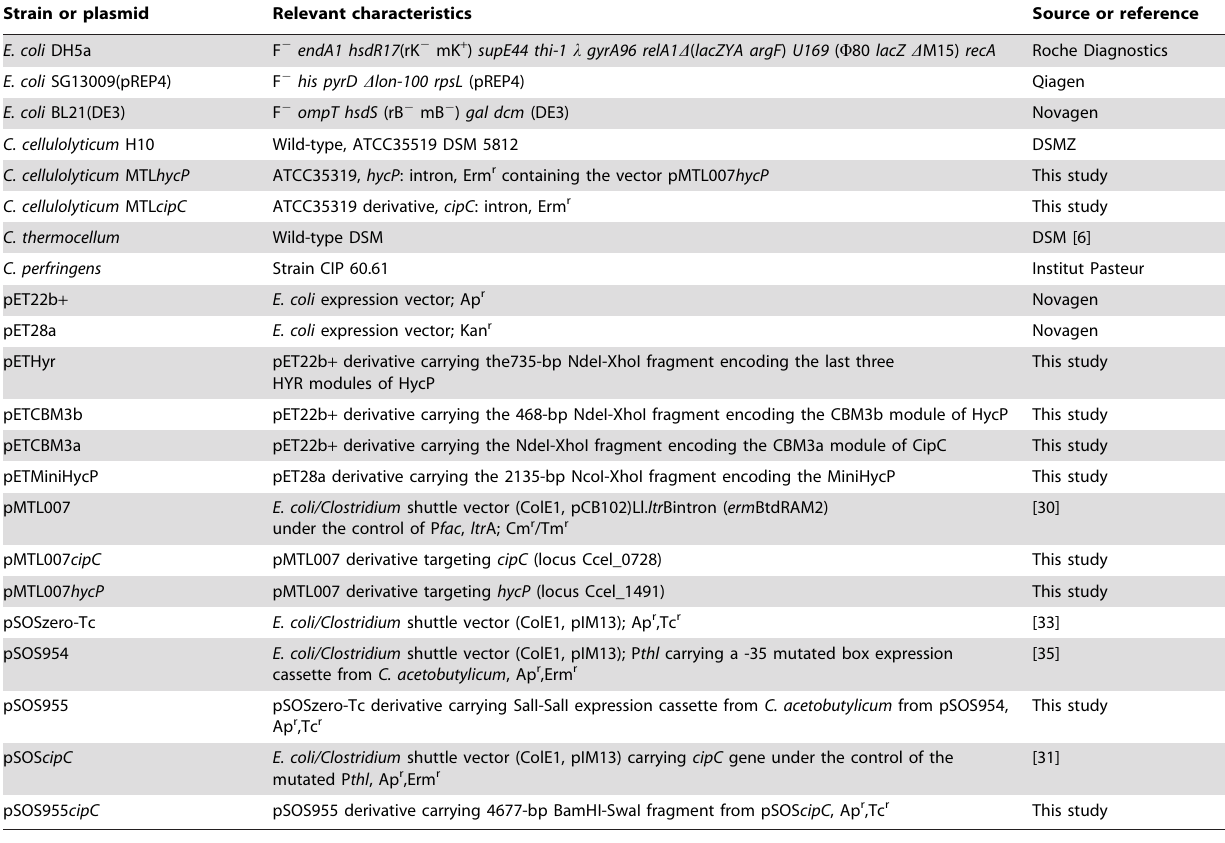
Table 3. Bacterial strains and vectors used in this